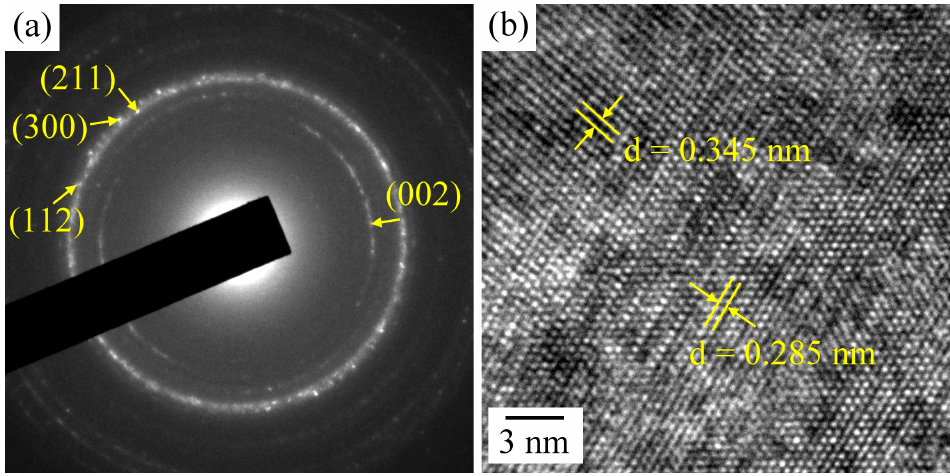
Figure 9. ( a ) SAED pattern taken from the middle area of the Ca–P layer (spot B in Figure 8a); ( b ) high-resolution TEM (HRTEM) image of the Ca–P layer.